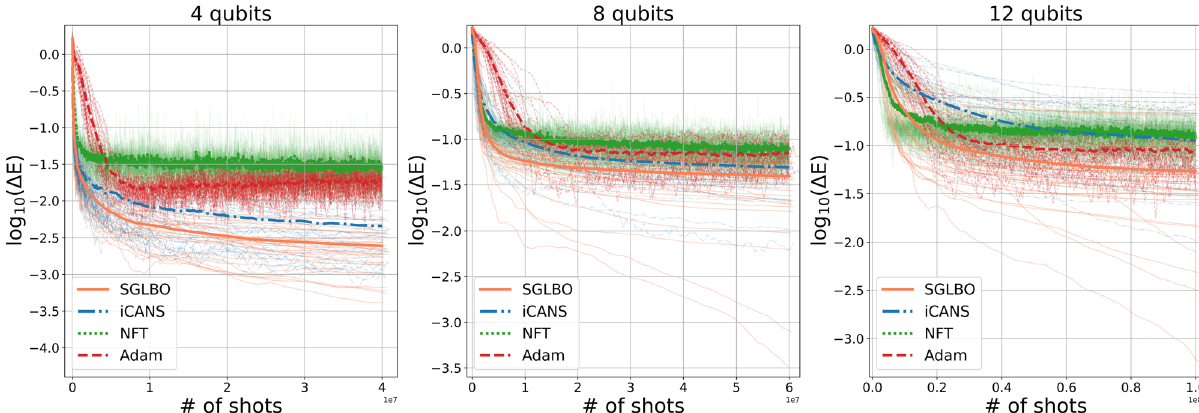
Fig. 3 Comparison of optimizers in terms of the performance on the VQE tasks. We optimize the cost function of the VQE for 1D transverse fi eld Ising model with n = 4, 8, 12 qubits in the noiseless case. In all plots, the x -axis represents the total number of measurement shots used during the optimization, and the y -axis represents the difference Δ E per site between the true value of the cost function (i.e., not evaluated with fi nite measurement shots) at each iteration and the minimum value of the cost function under the ansatz described in Fig. 2 with r = 4. For each optimizer, the thin lines represent each run repeated twice from fi fteen different initial points, and the thick line represents the average of these thirty runs. Signi fi cantly, the SGLBO outperforms the other state-of-the-art optimizers in terms of both the convergence speed and the achievable accuracy for, a broad region n = 4, 8, 12 of the number of